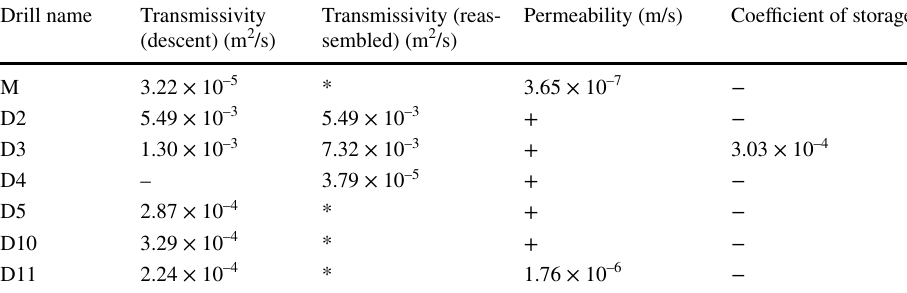
* The curve obtained does not make it possible to calculate the